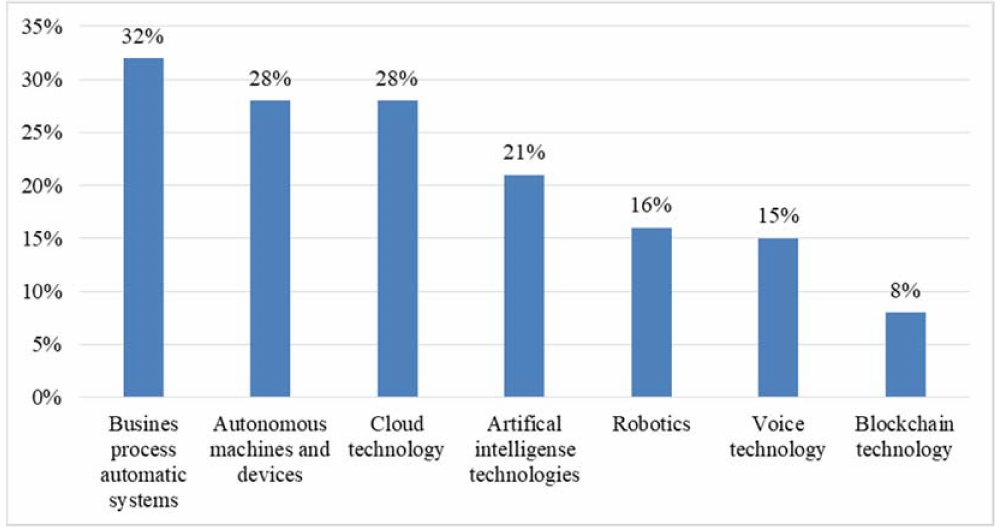
Figure 4. ICT, which will be most relevant in the field in the near future in activity of manufacturing enterprises of the Republic of